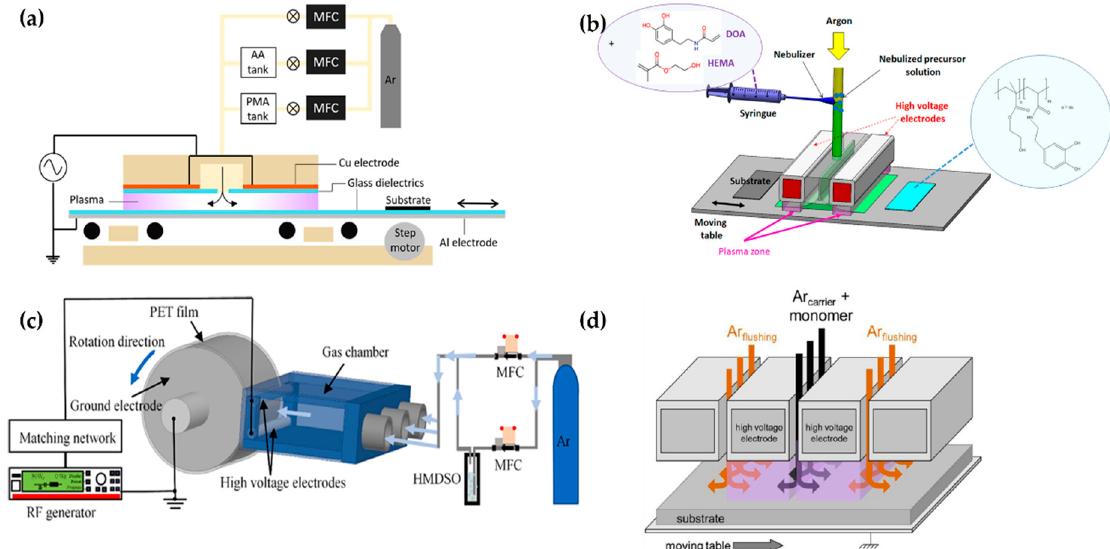
Figure 8. The polymerization systems using planar DBD with a movable substrate stage (bottom electrode) of ( a ) Demaude et al. [78], ( b ) Jalaber et al. [80], ( c ) Ma et al. [81], and ( d ) Loyer et al. [83].